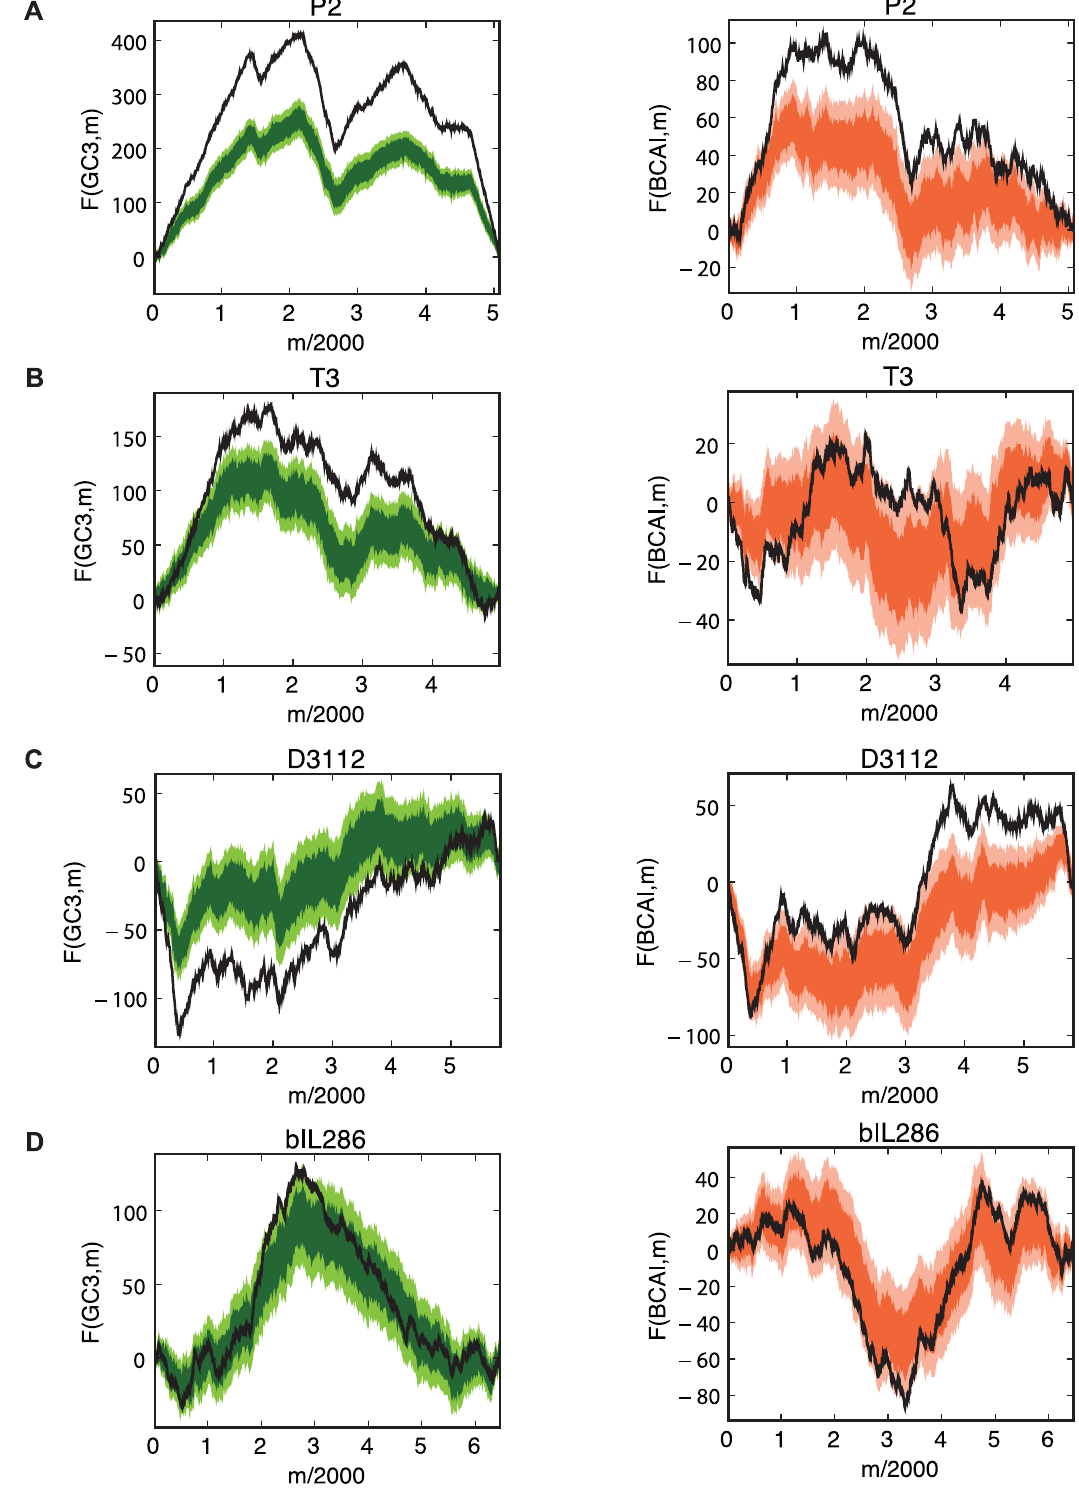
Figure 7. Green (left) and orange (right) randomization tests for several phages. Bacteriophages P2 (A) and T3 (B) both infect E. coli . Phage D3112 (C) infects P. aeruginosa . Phage bIL286 (D) infects L. lactis . T3 is the only non-temperate phage of this group. See Table 2 for combined Fisher p-values for these tests. In the case of bIL286, note the lack of evidence for codon bias evident in the green and orange tests for bIL286, as confirmed by the insignificant p -values in Table 2. In this case, we cannot rule out the possibility that the observed pattern in GC3 is determined completely by the amino acid and CAI sequence (green), or that the observed pattern in CAI is determined by the amino acid and GC3 sequence (orange).